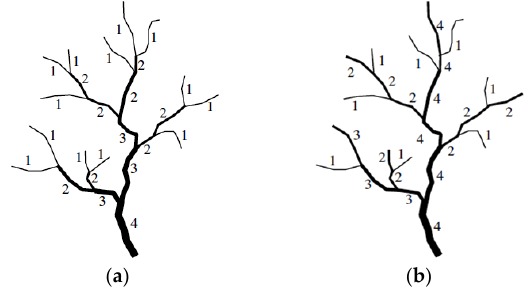
Figure 3. “Strokes” of a river network (from Li’s work [12]). ( a ) is a river network performed by the Horton-Strahler order scheme. ( b ) is the network after upstream routine, main streams are regarded as strokes.